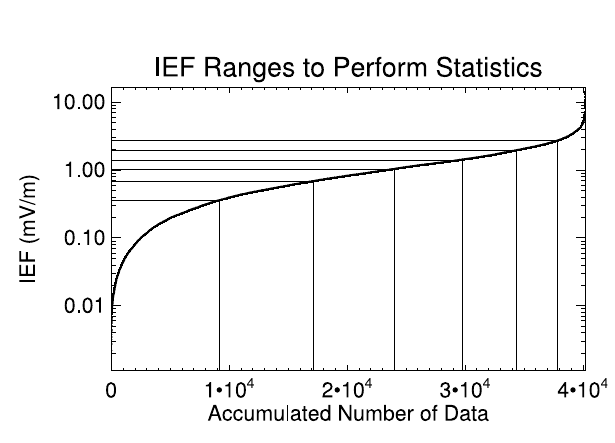
Fig. 1. Accumulated numbers of 5min data and IEF are compared in our database. We have divided data into seven categories sorted by